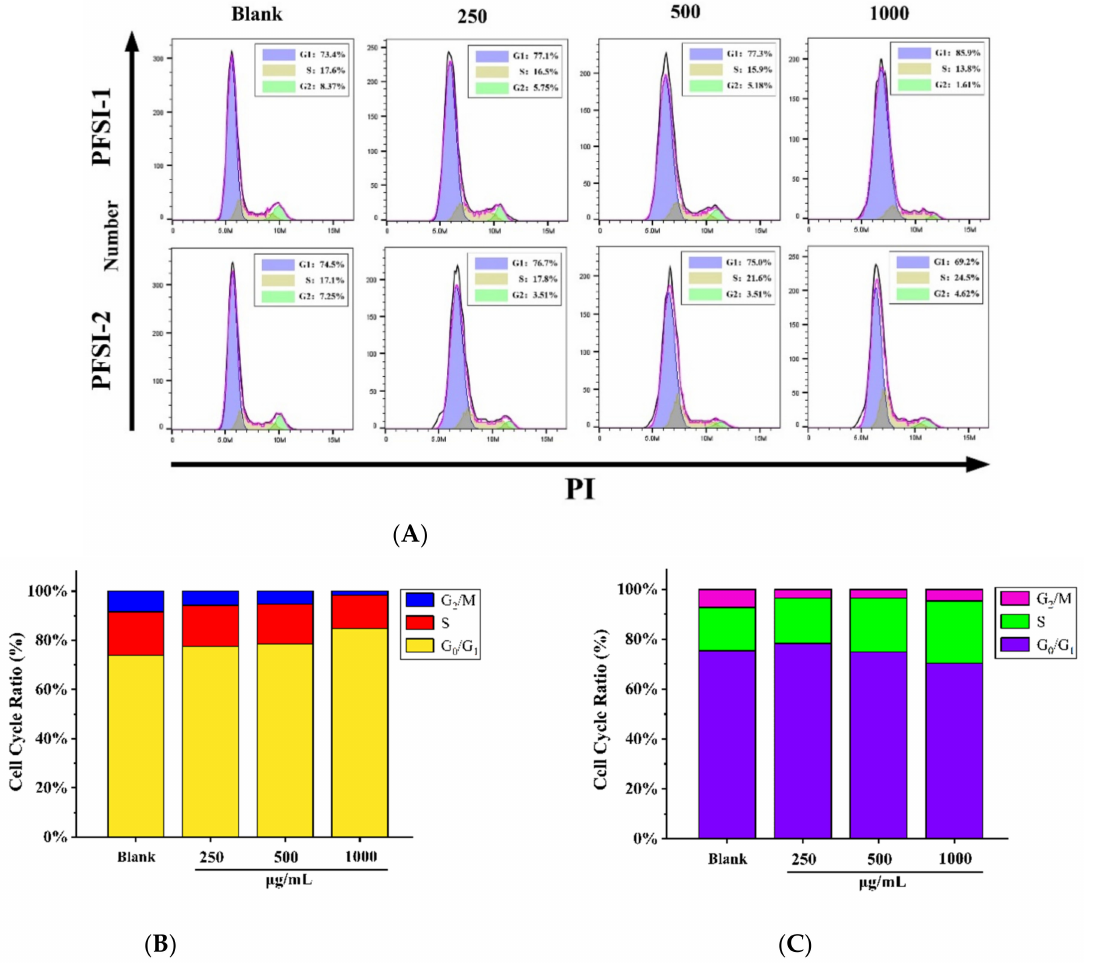
Figure 13. The influence of PFSI-1 and PFSI-2 on the cell cycle of SMMC 7721. (Note: ( A ) represents the red fluorescence at 488 nm recorded on the flow cytometer of PFSI-1 and PFSI-2 on SMMC 7721 cells; ( B ) represents PFSI-1 on SMMC 7721 cell cycle levels; ( C ) represents PFSI-2 on SMMC 7721 cell cycle